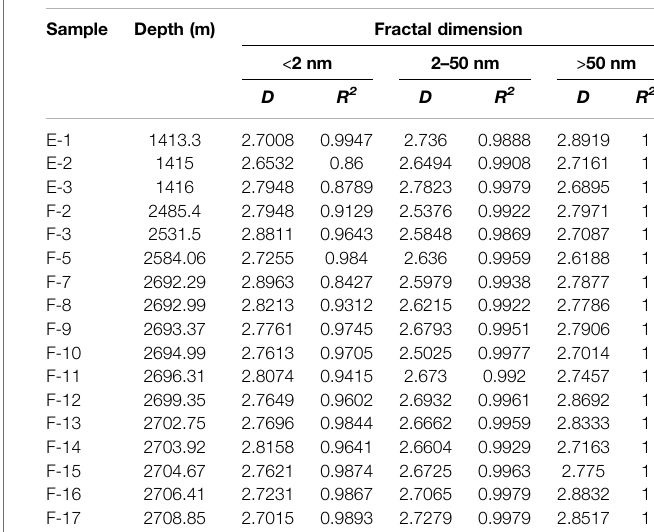
TABLE 2 | Tables of fractal dimension of Shanxi Formation shale